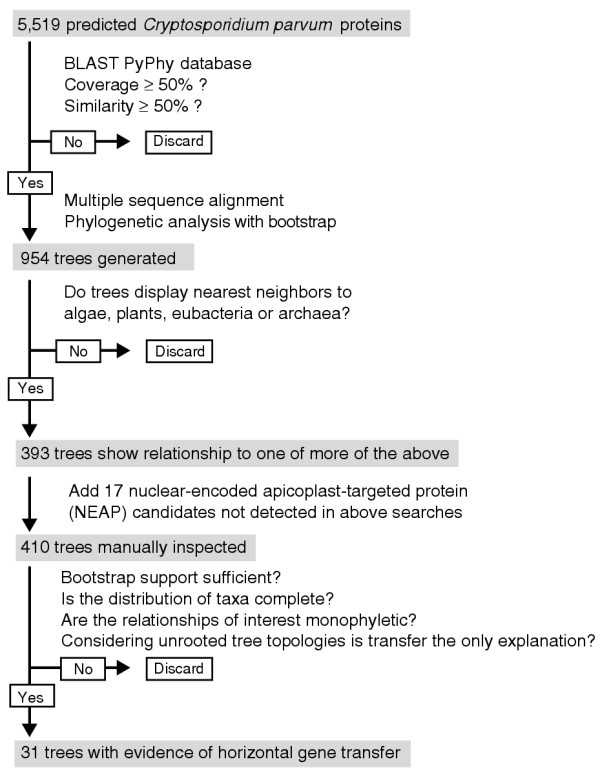
Phylogenomic analysis pipeline. The procedures used to analyze, assess and manipulate the protein-sequence data at each stage of the analysis are diagrammed.